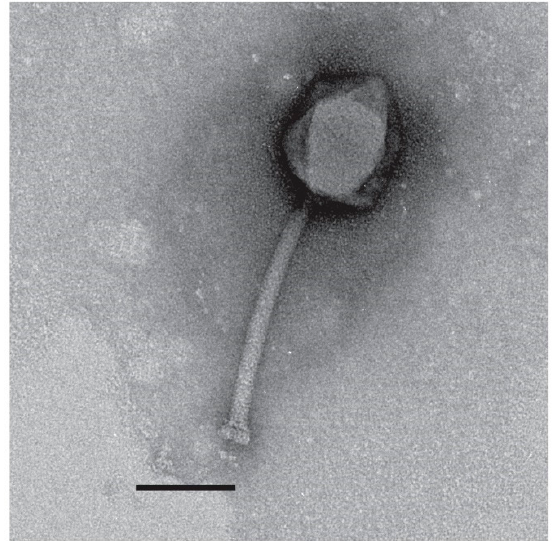
Figure 15. Transmission electron micrograph of the jumbo phage TRS5, stained with 2% w/v uranyl acetate. The scale bar represents 100 nm.